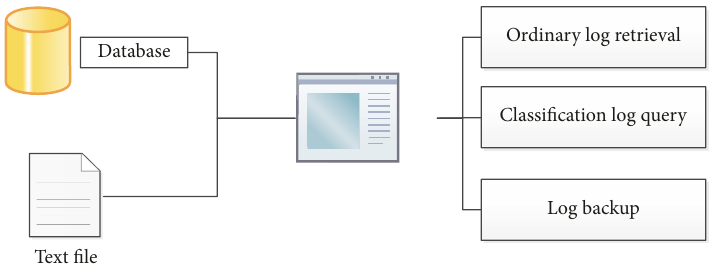
Figure 3: Log subsystem management interface functional structure.